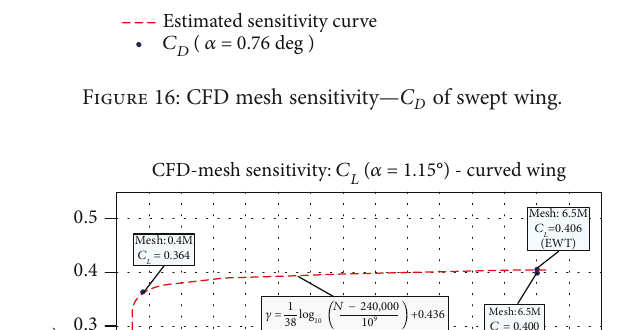
Figure 16: CFD mesh sensitivity — C